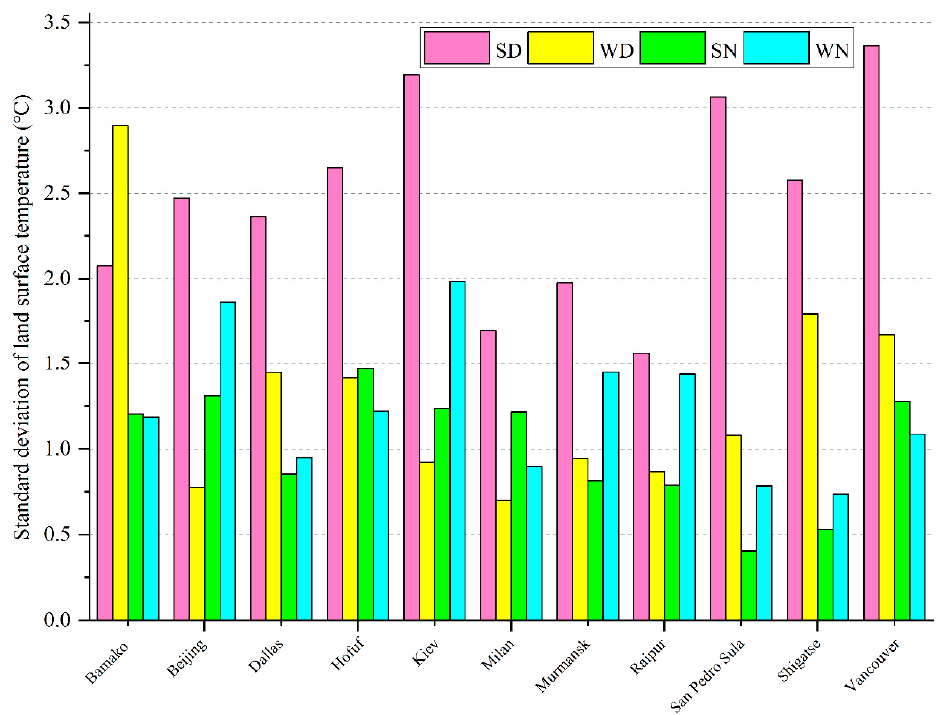
Figure 2. Standard deviations of land surface temperatures during the daytime and nighttime in the summer and winter in the eleven selected cities in different global climatic zones. Unit: °C. SD, WD, SN and WN refer to the summer daytime, winter daytime, summer nighttime and winter nighttime, respectively.